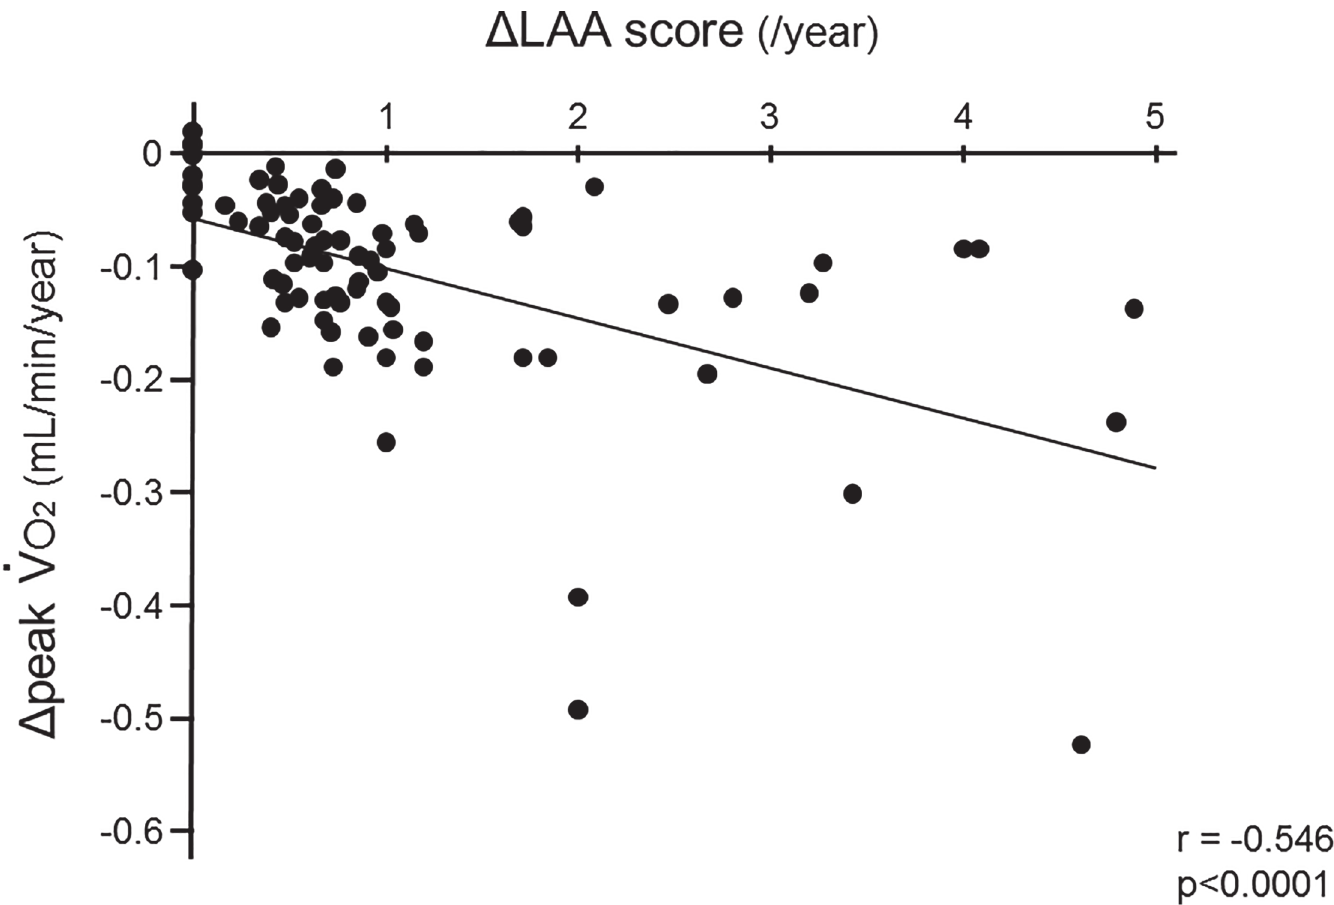
Fig 5. Relationship between the decline in aerobic capacity and progression of emphysema. The mean annual changes in peak _ V O 2 ( Δ p _ V O 2 ) were significantly correlated with those in the total LAA scores ( Δ LAA) (p < 0.0001, r = -0.546).